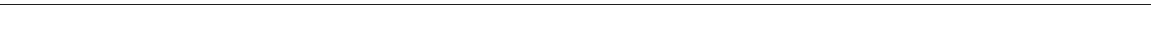
Fig. 4 PHA-4 responses to nucleolar stress. a Nile Red staining of fi xed worms. Synchronized smg-1 ( cc546 ) ;pha-4 ( zu225 ) eggs were hatched in M9 buffer to L1 worms at 24 ℃ . Subsequently, L1 worms were transferred to NGM plates, raised at 20 ℃ , and then collected when they reached 1 day of adulthood for analysis of lipid contents. Representative animals; the anterior is indicated on the left and the posterior is indicated on the right. Scale bar represents 20 μ m. b Distribution of the lipid droplet size (% lipid droplets) as measured by Nile Red staining of fi xed worms from a . Data are presented as the means ± SD of 10 animals for each worm strain. Signi fi cant difference between WT and a speci fi c worm strain, ANOVA, *** P < 0.001. NS, no signi fi cant difference. c , d Percentage of triacylglycerol (% TAG) in total lipids (TAG + phospholipids, PL) analyzed by TLC/GC. Data are presented as the means ± SD of four biological repeats. Signi fi cant difference between WT and a speci fi c worm strain, Student ’ s t -test, *** P < 0.001. NS, no signi fi cant difference. e Relative mRNA expression of pha-4 in WT and mutant worms. Data are presented as the means ± SD of three biological repeats. Signi fi cant difference between WT and a speci fi c worm strain, ANOVA, *** P < 0.001, * P < 0.05. f Confocal microscopy of PHA-4::GFP { wgIs37[pha-4 :: GFP] } in WT, rrp-8 ( kun54 ), rsks-1 ( ok1255 ), and AD-treated worms at 1 day of adulthood. BF, bright fi eld. Representative animals; the anterior is indicated on the left and the posterior is indicated on the right. Scale bar represents 10 μ m. g Quanti fi cation of the fl uorescence intensity of PHA-4::GFP from f . Data are presented as the means ± SD of at least 20 worms for each worm strain. Signi fi cant difference between WT and rrp-8 ( kun54 ) mutant background, ANOVA, *** P < 0.001. h Immunoblotting of PHA-4::GFP { wgIs37[pha-4 :: GFP] } with anti-GFP antibody in WT, rrp-8 ( kun54 ), rsks-1 ( ok1255 ), and AD-treated background worms at 1 day of adulthood. WT worms without GFP was used as a negative control and WT worms with PHA-4a::GFP { kunEx136[Pvha-6 :: pha-4a :: GFP] } as a positive control. The relative protein levels of PHA-4::GFP were